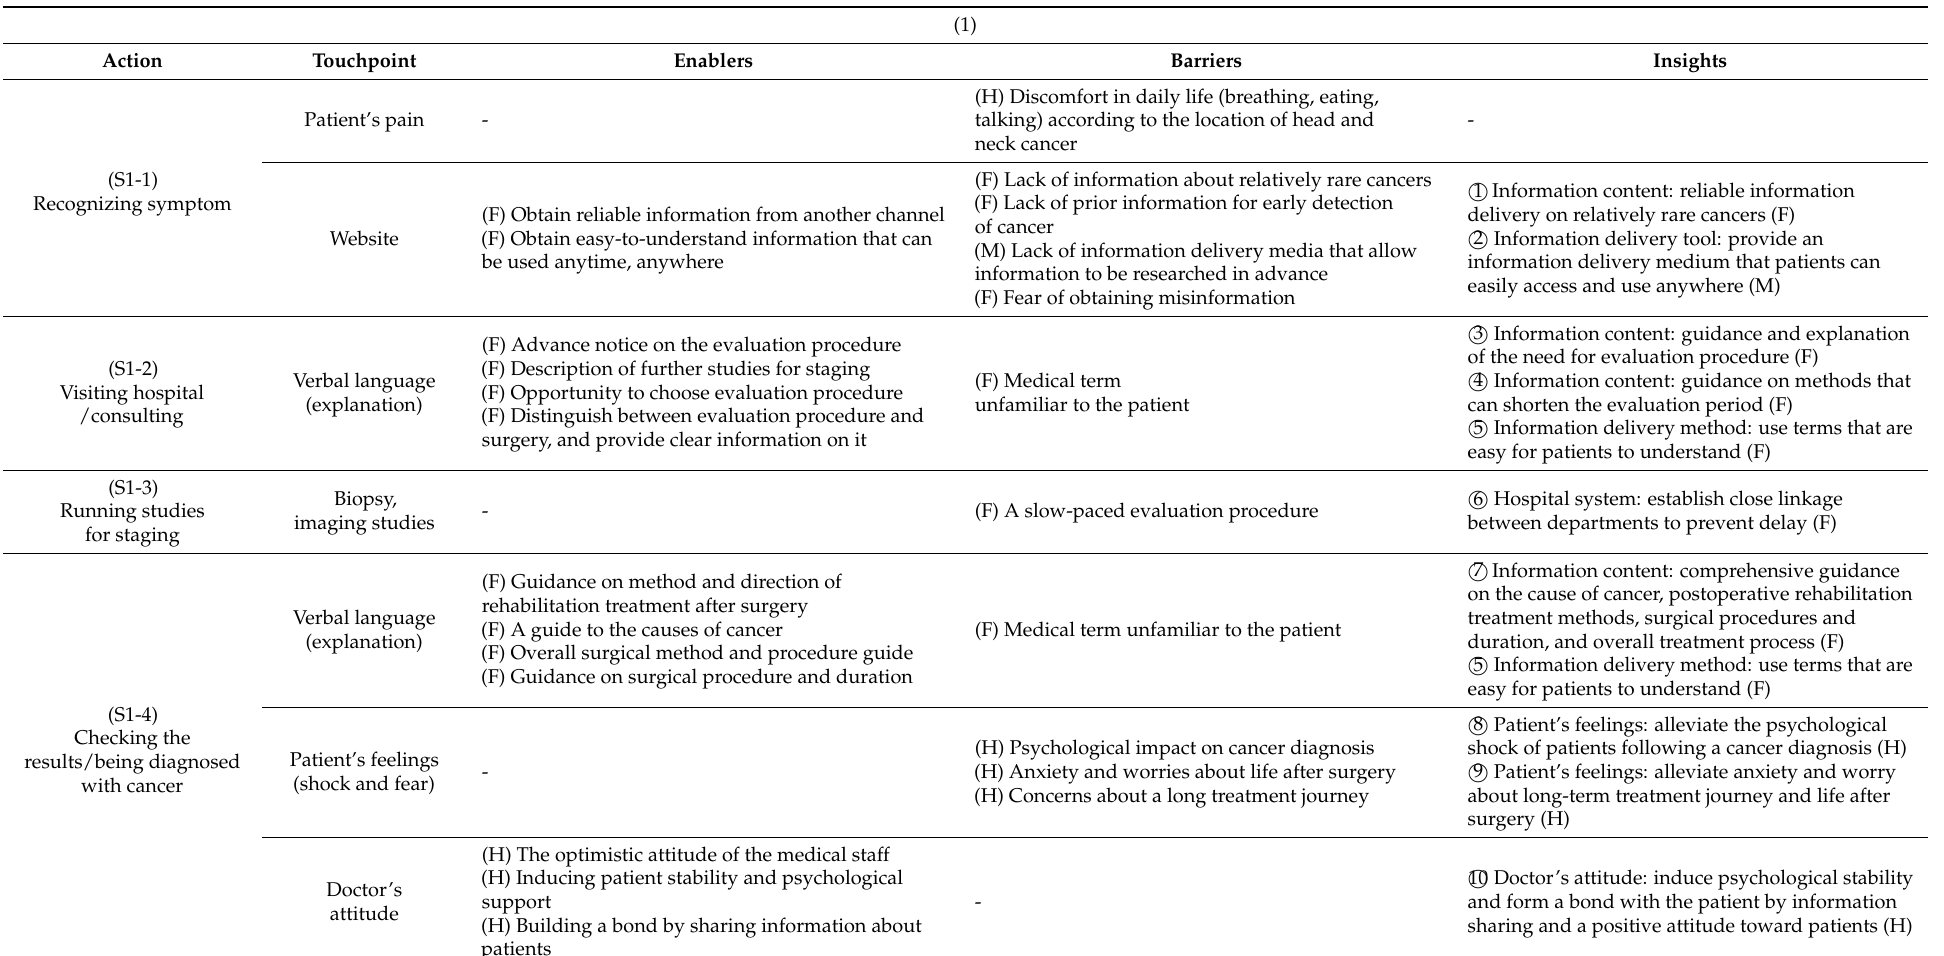
Table 3. (1) Journey Stage 1: studies for cancer diagnosis and staging. (2) Journey Stage 2: pre-operative counseling. (3) Journey Stage 3: getting operation